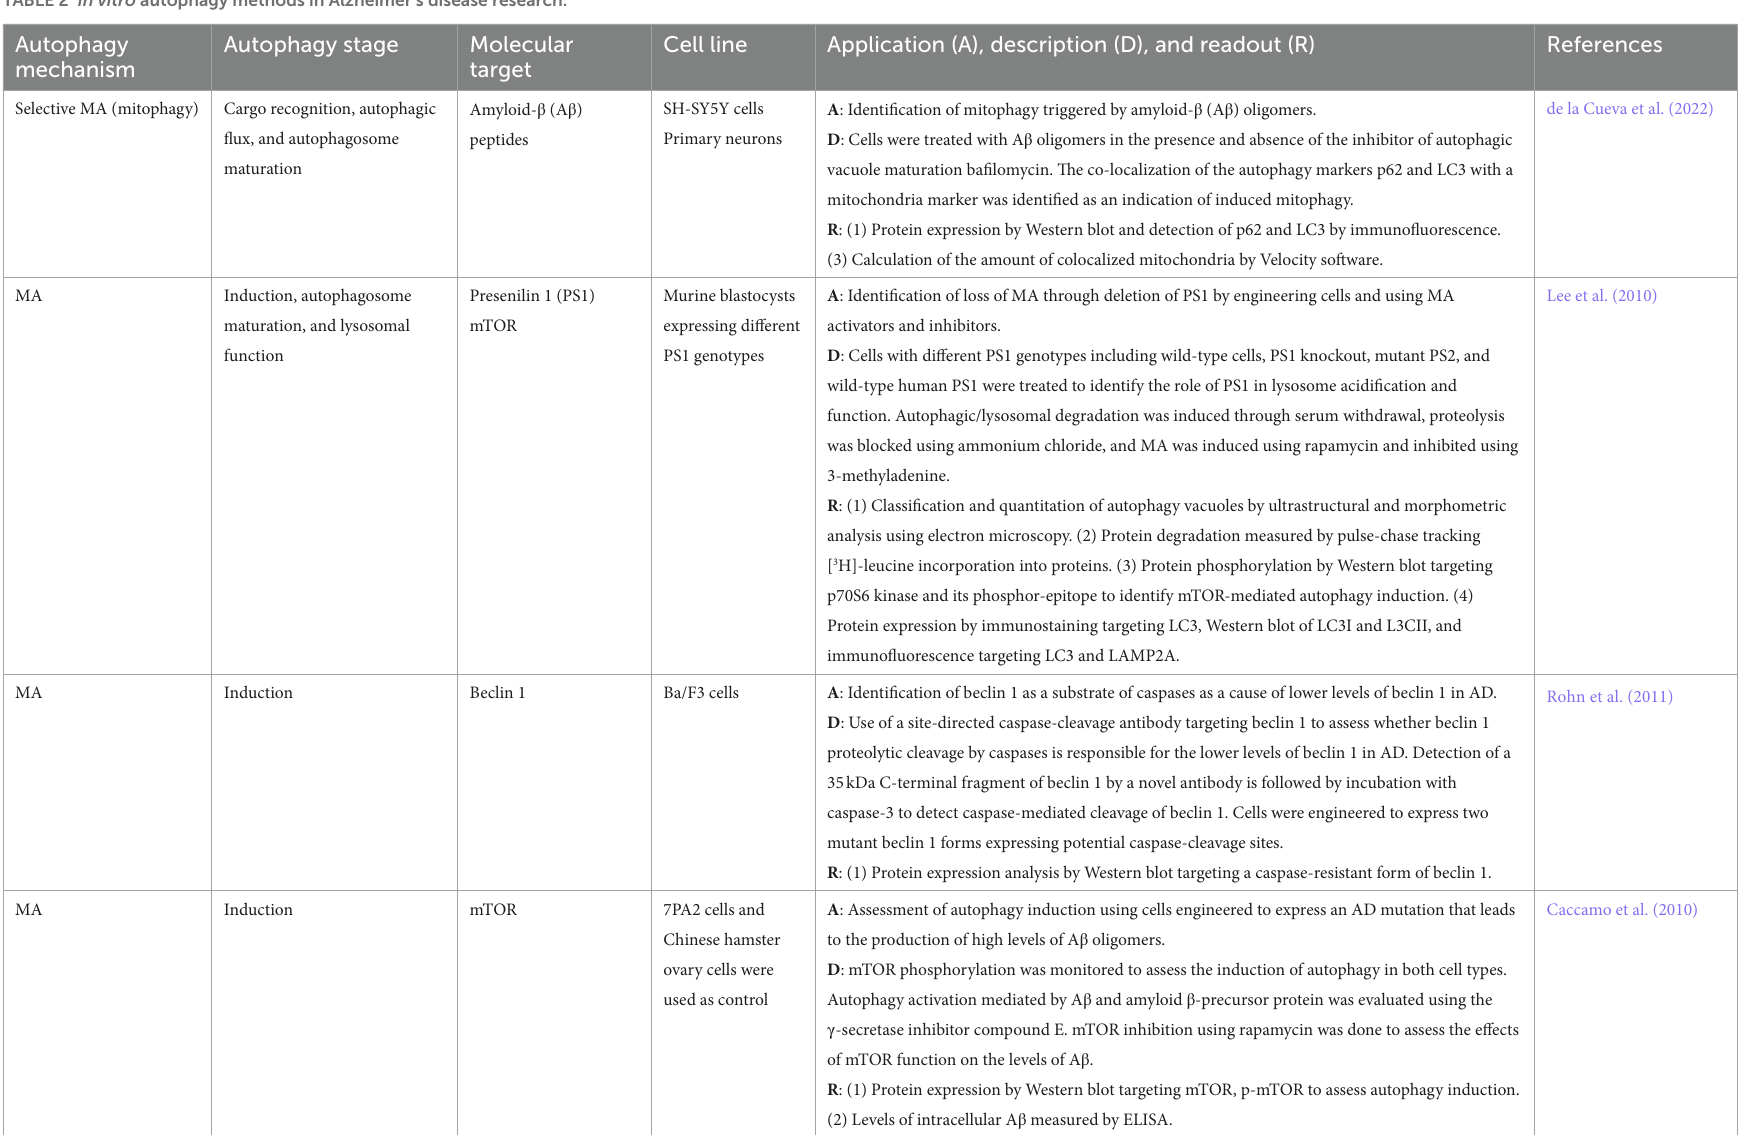
TABLE 2 In vitro autophagy methods in Alzheimer’s disease